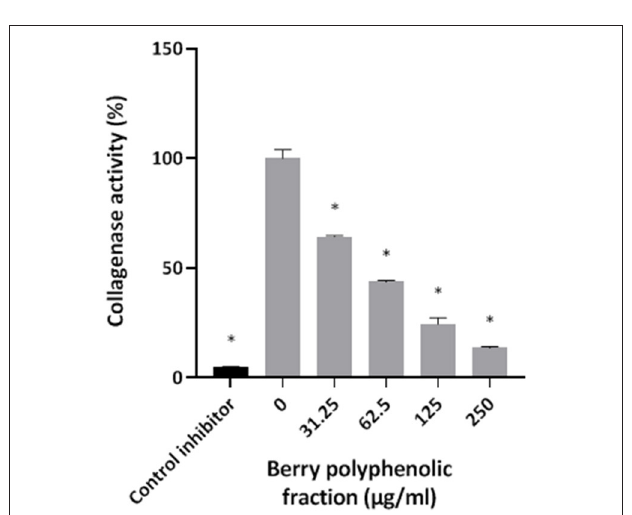
FIGURE 4 | Effect of the berry polyphenolic fraction on the collagenase activity of P. gingivalis . Leupeptin was used as a control inhibitor. A relative value of 100% was assigned to the degradation of type I collagen in the absence of the berry polyphenolic fraction. Results are expressed as the means ± SD of triplicate assays from three independent experiments. *Significant inhibition ( p < 0.01) compared to the control.